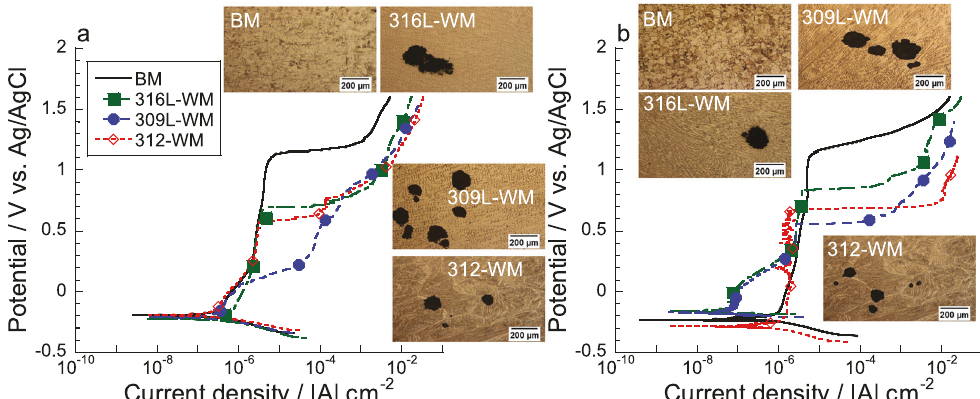
Fig. 6 Potentiodynamic polarization. a Representative potentiodynamic polarization curves for BM and weldments in PBS. b PBS + 10 g L − 1 WP corresponding post-polarization LOM images.